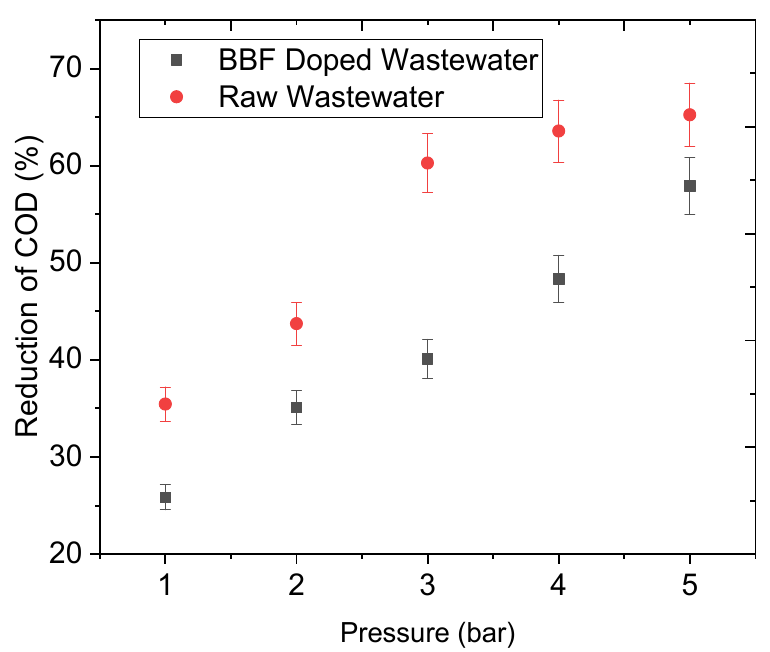
10 of 16 Figure 5. Evaluation of the effect of pH on dye removal in industrial discharge: Δ P = 4 bar; [BBF] = 40 mg/L; [COD] doped wastewater = 220 mg O 2 /L; Turbidity doped wastewater = 28 FNU; and treatment time = 15 min. 3.3.2. Effect of Pressure The main driving force in a membrane based on liquid-phase separations is operating pressure, which is directly proportional to the wastewater treatment cost and higher flux rates [43–45] . For that reason, we focused on the effect of pressure was investigated by varying from 1 to 5 bars. The COD and color removal rates in industrial waters are shown